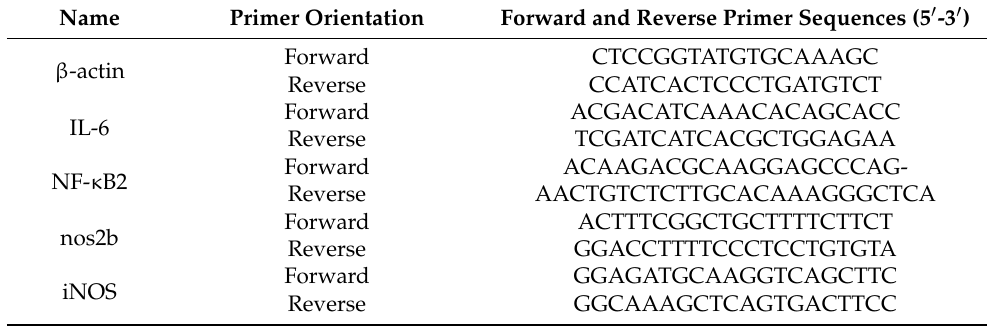
Table 1. The specific primer pairs used in this study.